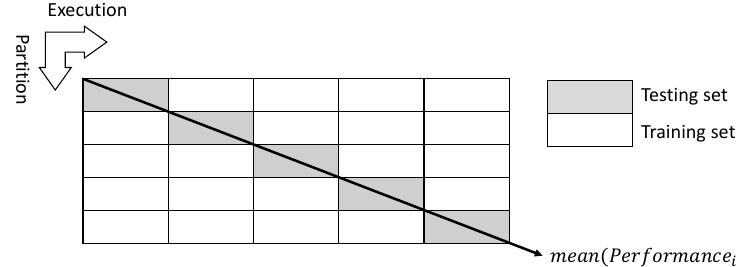
Figure 4. Representation of the five-fold cross-validation scheme, validation set is